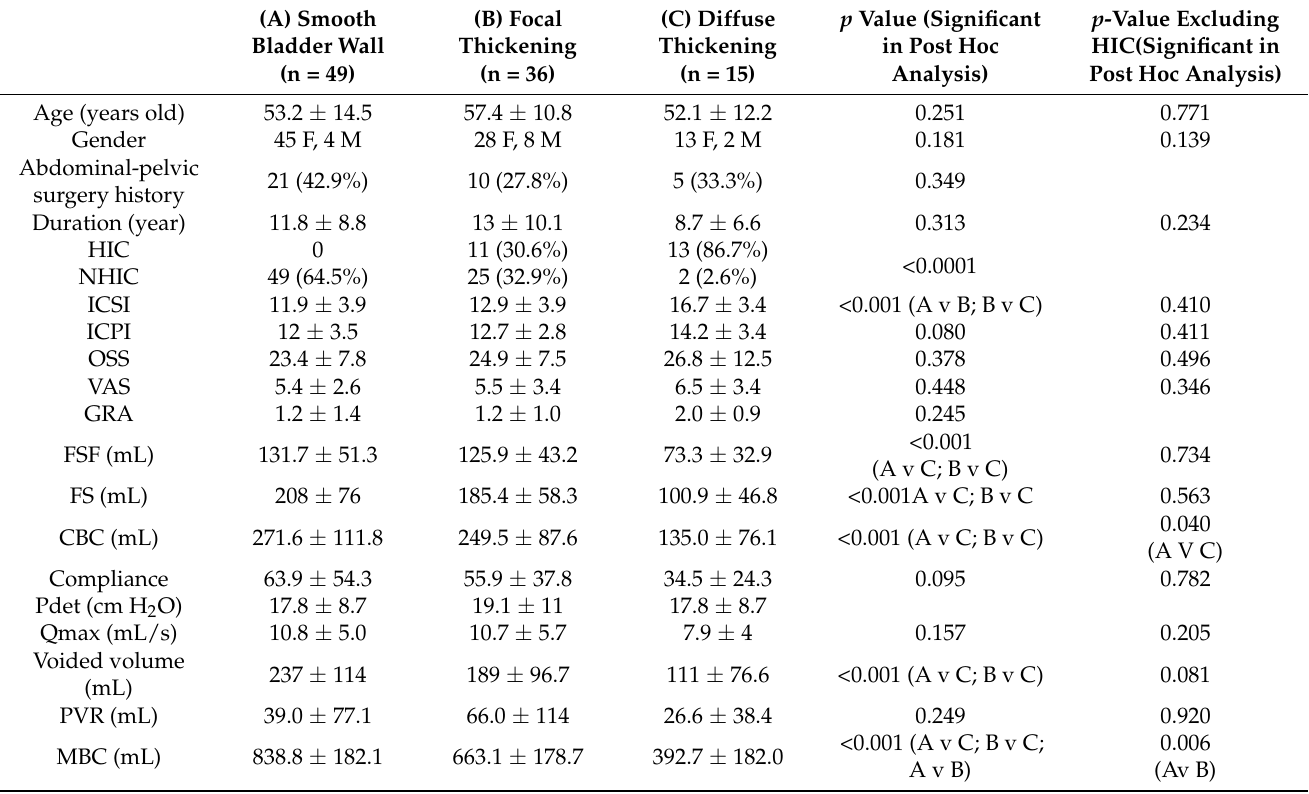
Table 1. Patient demographics and clinical data of the 100 patients with interstitial cystitis/bladder pain